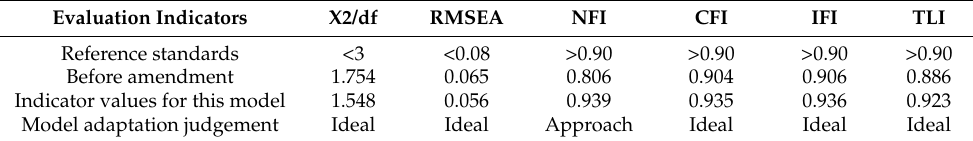
Table 7. Results of model fitness test indicators.